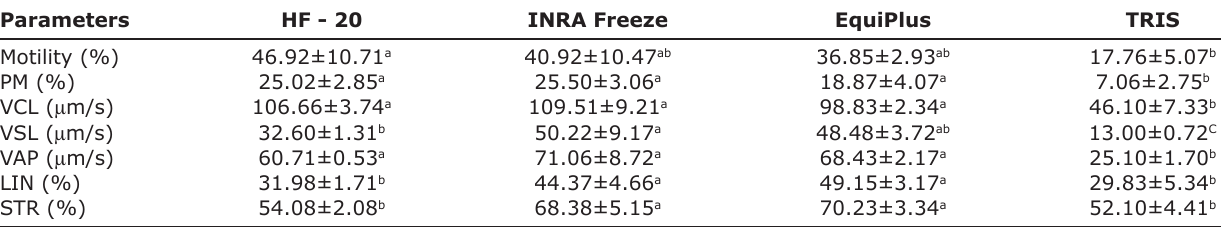
Table-4: Effect of different extenders on the post-thawed stallion semen and on the motility pattern. Parameters